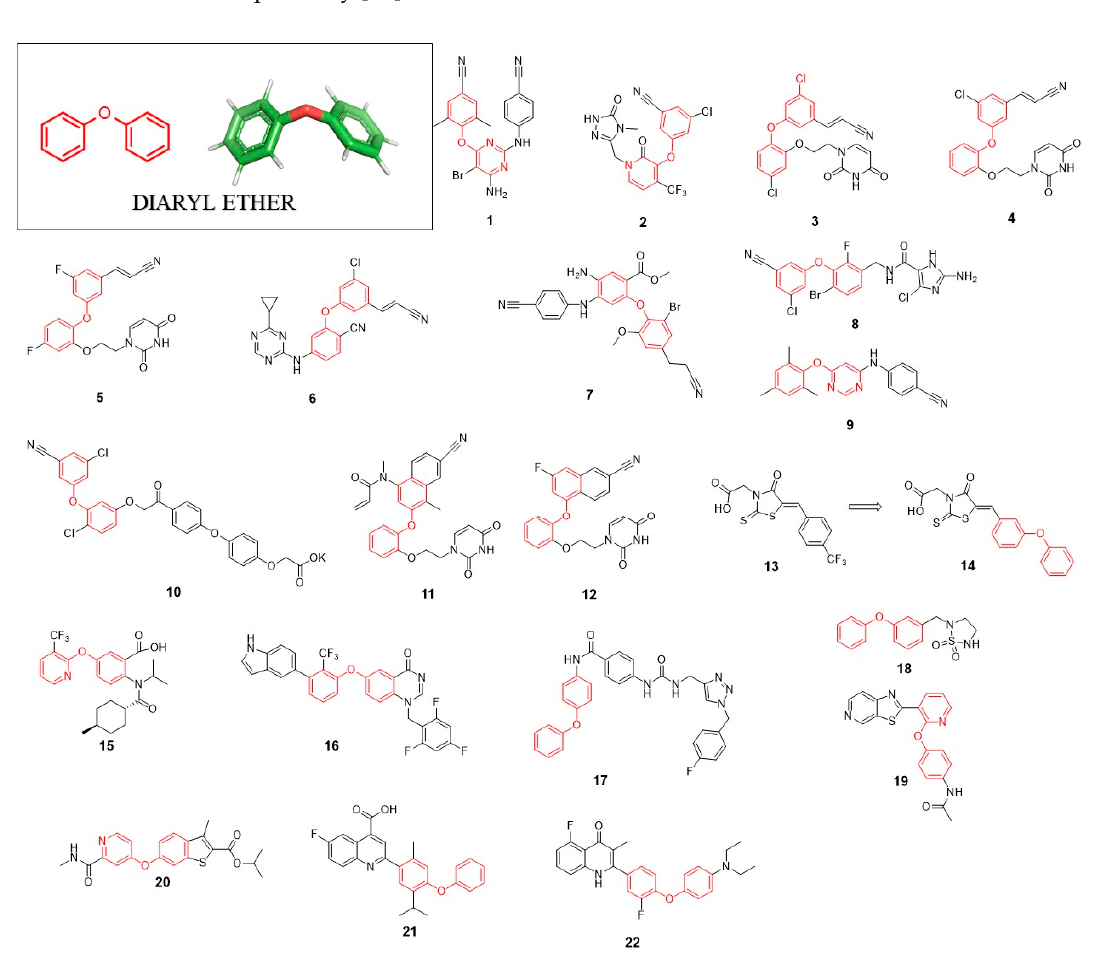
Figure 2. Antivirals with diaryl ether (DE) structure.